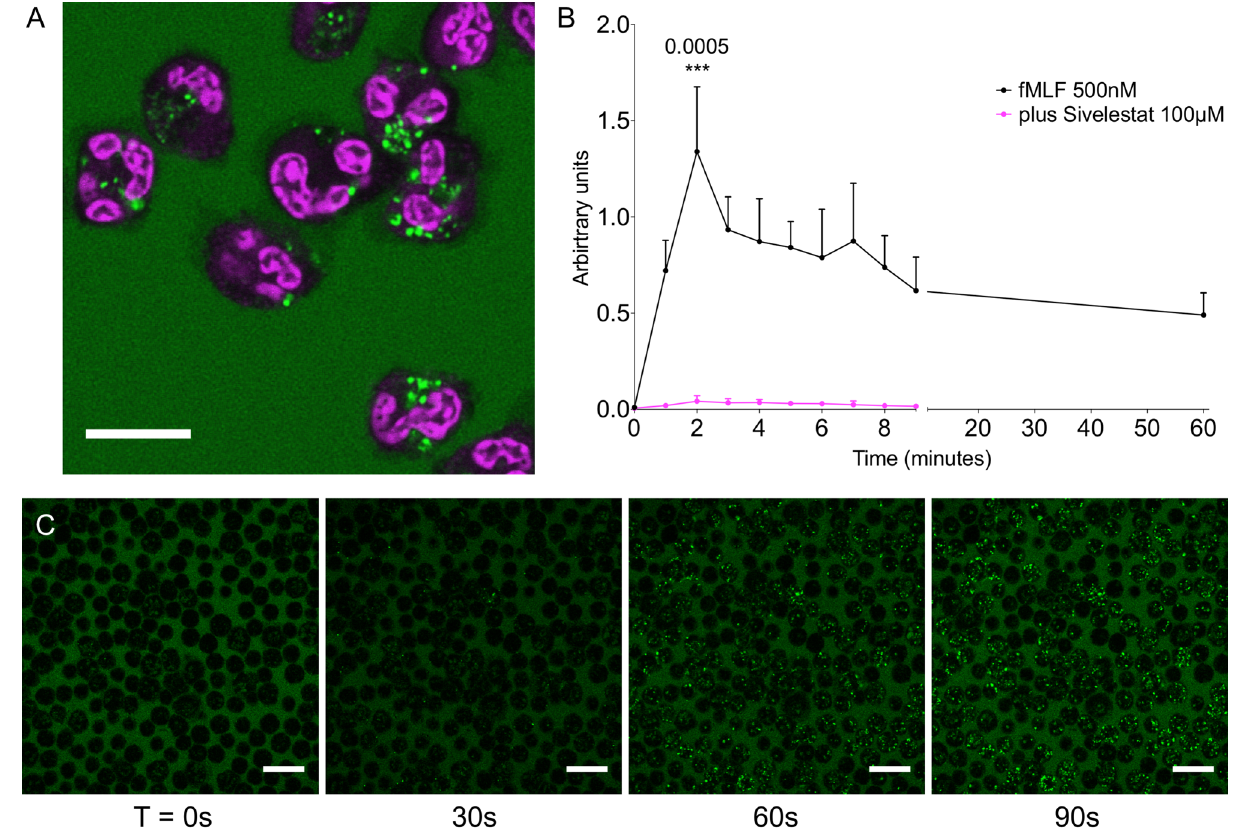
Figure 2. NAP selectively identifies activated neutrophils. (A) Activated neutrophils take up NAP (green) to exhibit bright green intracellular punctate fluorescent signal. Cells were stained with the nucleic acid counterstain Syto 60 (magenta). Scale bar 10 µm. (B) Graph illustrating results of objective image analysis pooled from three separate experiments (mean + SD). Dots are mean (± SD). Black line—primed neutrophils activated with fMLF (500 nM) at t = 10 s. Magenta line—primed neutrophils in continued presence of Sivelestat 100 µM, activated with fMLF (500 nM) at t = 10 s. Statistical analysis by 2-way ANOVA with Bonferroni’s correction, p = 0.0082 between conditions up to 9-min time point, 3 degrees of freedom, an exact multiplicity adjusted p value is given with the figure at t = 2 min for illustrative purposes. N = 3 (distinct samples) for fMLF condition, N = 2 (distinct samples) for Sivelestat condition. (C) Confocal microscopy images of human neutrophils activated using 500 nM fMLF shown at various time points in the presence of NAP (5 µM, green). Images are representative from three separate experiments. Scale bar 20